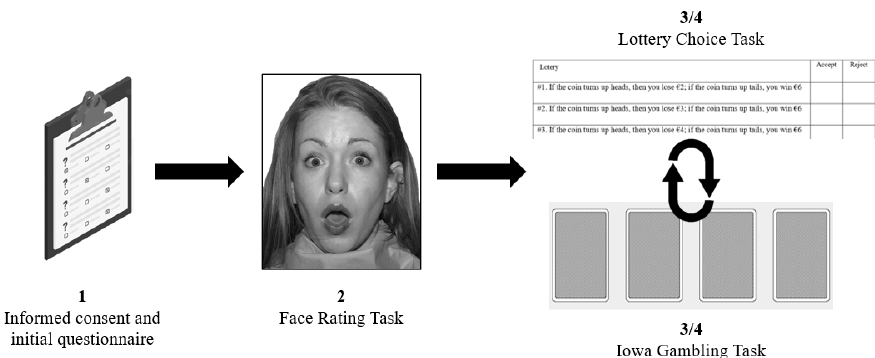
Figure 1. Experimental session procedure. The order in which the tasks were performed during the experimental session is shown. The Iowa Gambling Task and Lottery Choice Task were counterbalanced across participants.